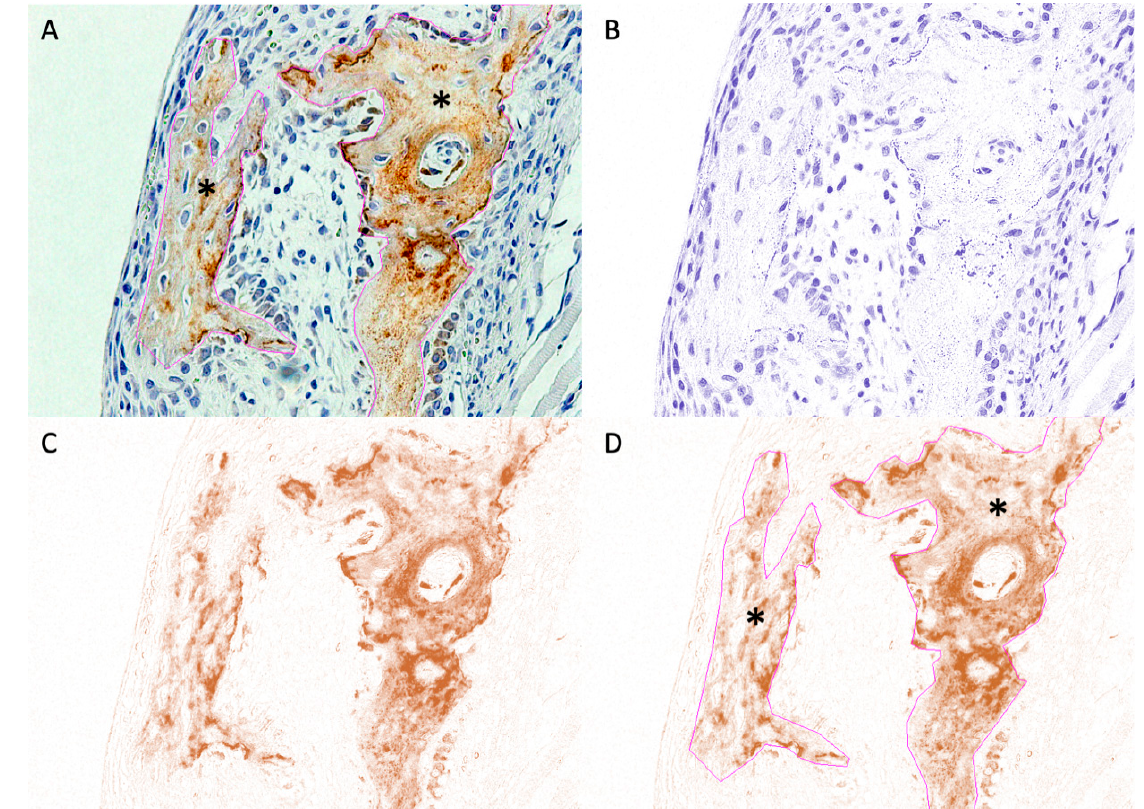
Figure 4. Example of ROI selection for areas containing new bone (anti-OCN IHC staining). ( A ) Original image with overlay of the selected ROI. *, selected area. ( B ) Hematoxylin-stained image separated from the original image. ( C ) DAB-stained image separated from the original image. ( D ) Superimposition of the saved ROI onto the DAB-stained image. *, selected area.